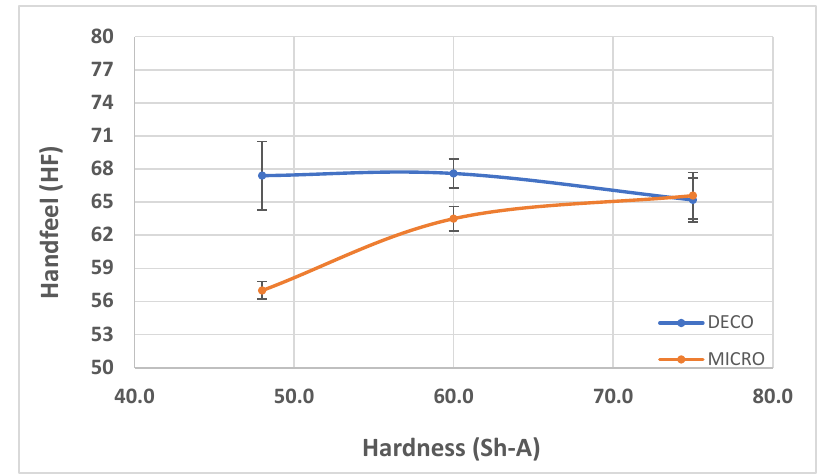
Figure 9. Handfeel comportment with the increase in rubber hardness.